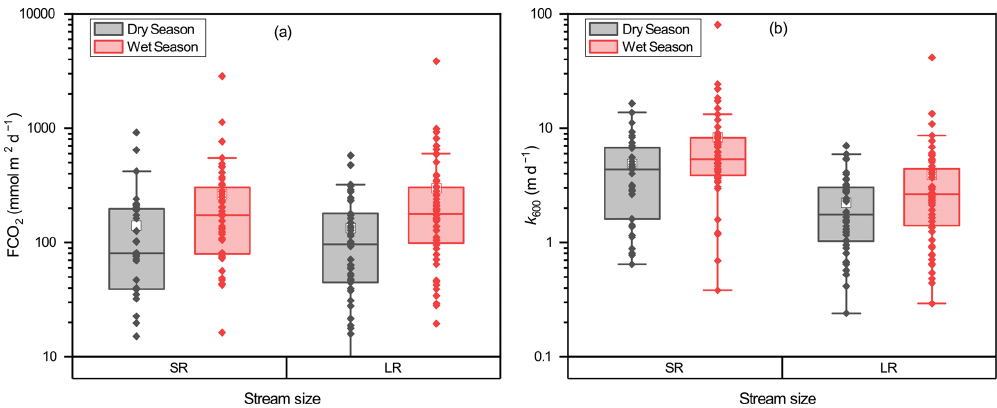
Figure 5. Relationship between stream size and (a) FCO 2 and (b) k 600 . The box mid-lines represent medians; the interquartile range (IQR) is represented by the top and bottom of the box, respectively; whiskers indicate the range of 1.5 IQR; the white square symbols represent means, and the other symbols represent FCO 2 and k 600 values for each sampled site.